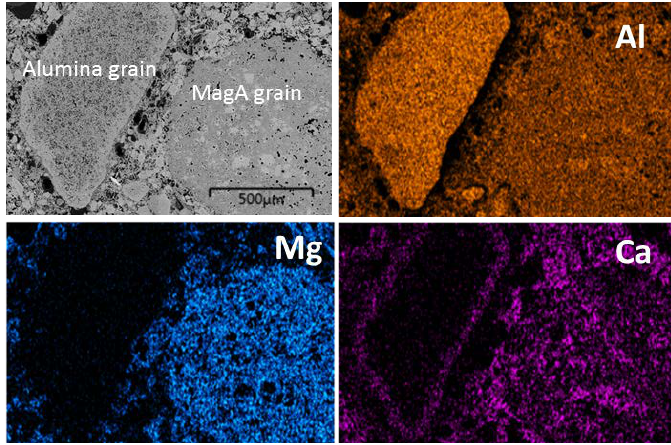
Figure 12. Element distribution in the non-infiltrated zone of the MagA-gun.